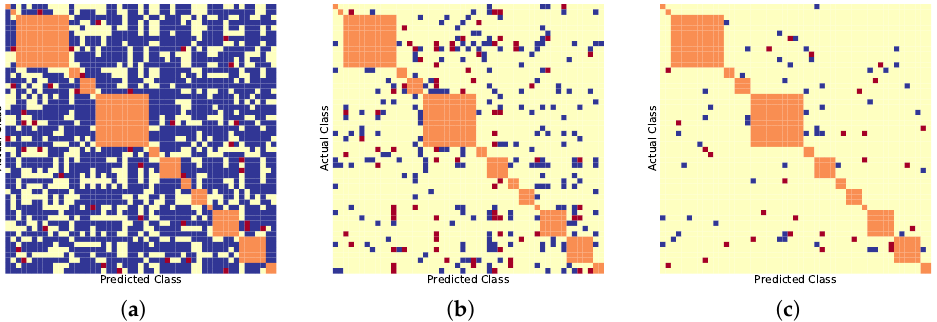
Figure 7. BDCM results on VMMRDB-51 [1] using different model recogniser backbones. Blue, yellow, and red dots mark the positions filled in with 1, 0, and − 1, respectively. Orange dots mark the different vehicle models that have the same make. ( a ) AlexNet [15] backbone, (#blue, #yellow, #red) = (1523, 734, 41). ( b ) ResNet50 [16] backbone, (#blue, #yellow, #red) = (232, 1985, 81). ( c ) DenseNet201 [17] backbone, (#blue, #yellow, #red) = (52, 2217,